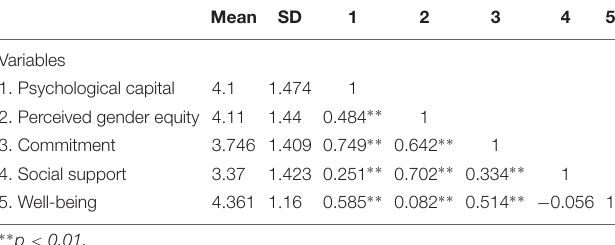
TABLE 1A | Means, standard deviations, and inter correlations among study variables. Mean SD